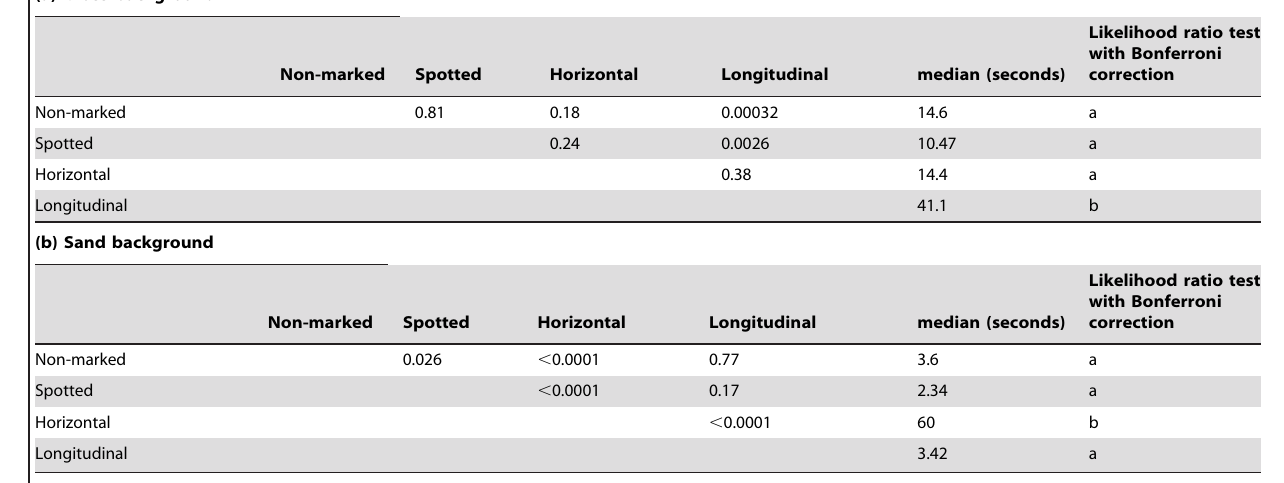
(a) Grass background